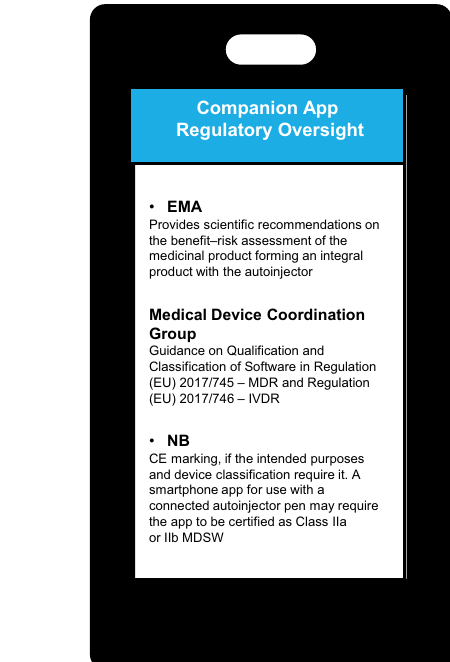
Fig. 4 Regulatory considerations for an insulin pen-connected medical device. The roles and responsibilities of regulatory bodies in the assessment of medical devices used in combination with a medicinal product. CE Conformitè Europëenne, EMA European Medicines Agency, EU European Union, IVDR In Vitro Diagnostic Devices Regulation, MDR Medical Device Regulation, MDSW medical device software, NB Noti fi ed Body, NCA National Competent